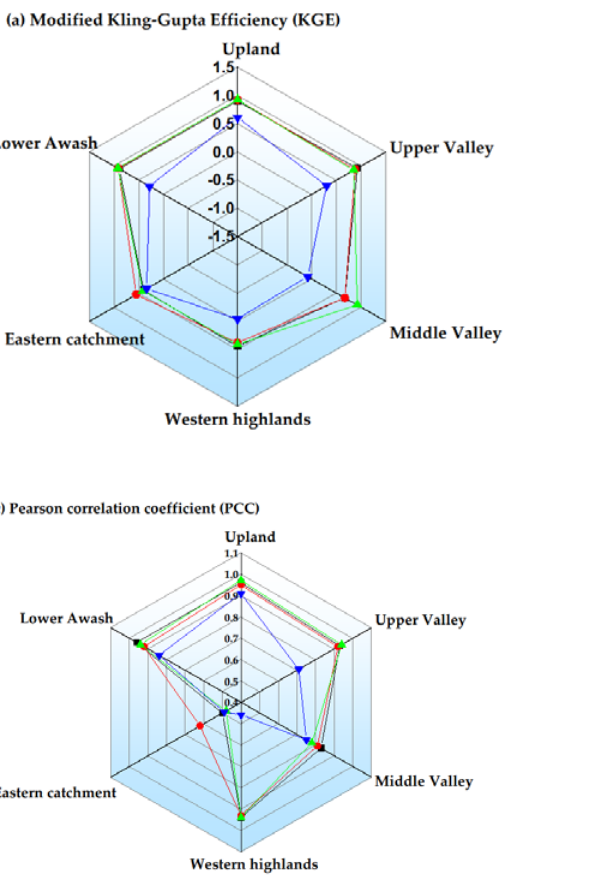
Figure 7. Comparison of statistics of satellite rainfall using a radar chart.